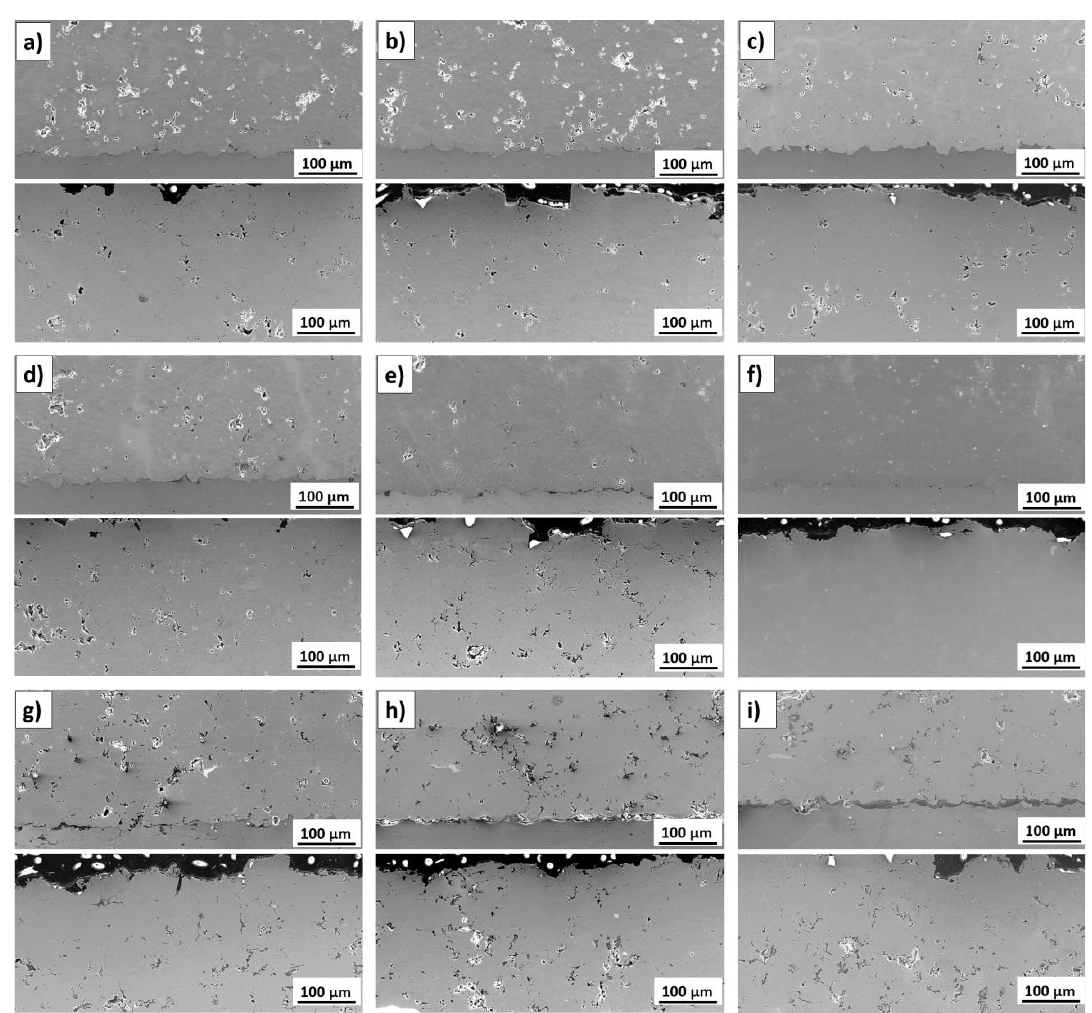
Figure 3. Microstructure of the cold-sprayed Ti coatings (near substrate — upper picture, top — picture below) deposited at standoff distances of: ( a ) 20 mm, ( b ) 30 mm, ( c ) 40 mm, ( d ) 50 mm, ( e ) 60 mm, ( f ) 70 mm, ( g ) 80 mm, ( h ) 90 mm, and ( i ) 100 mm.